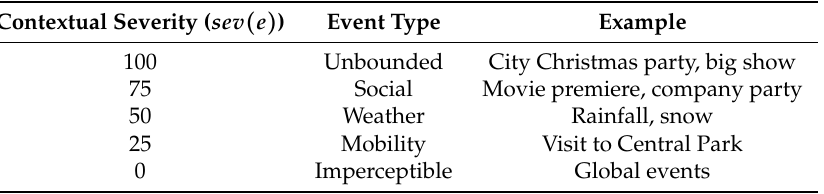
Table 2. Contextual severity levels for prioritization of